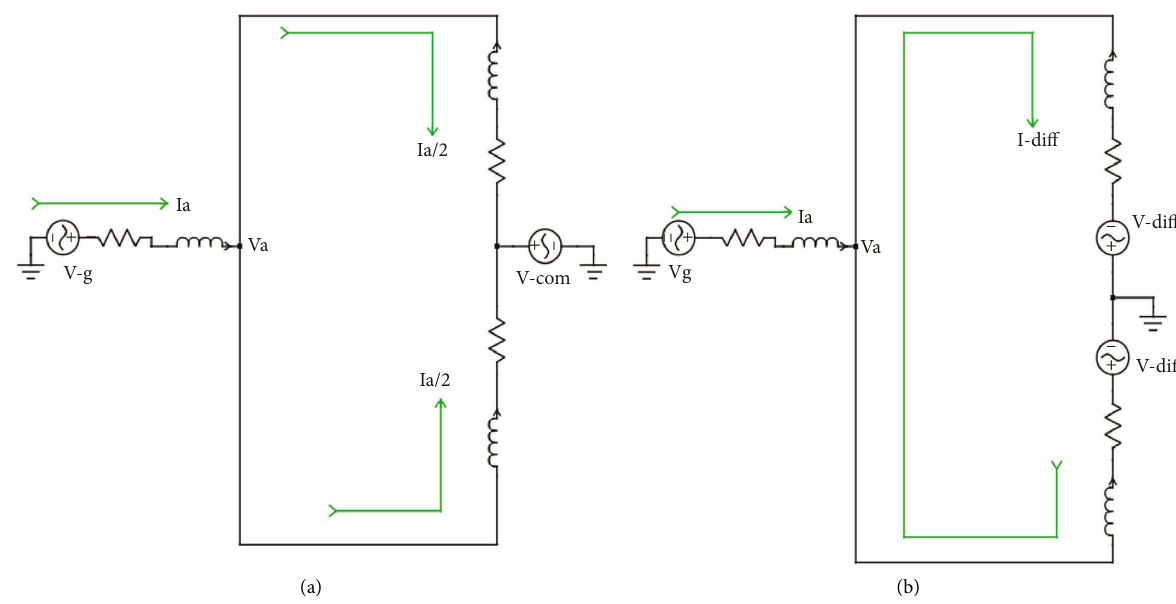
Figure 5: Modes of operation of MMC. (a) Common mode and (b) differential